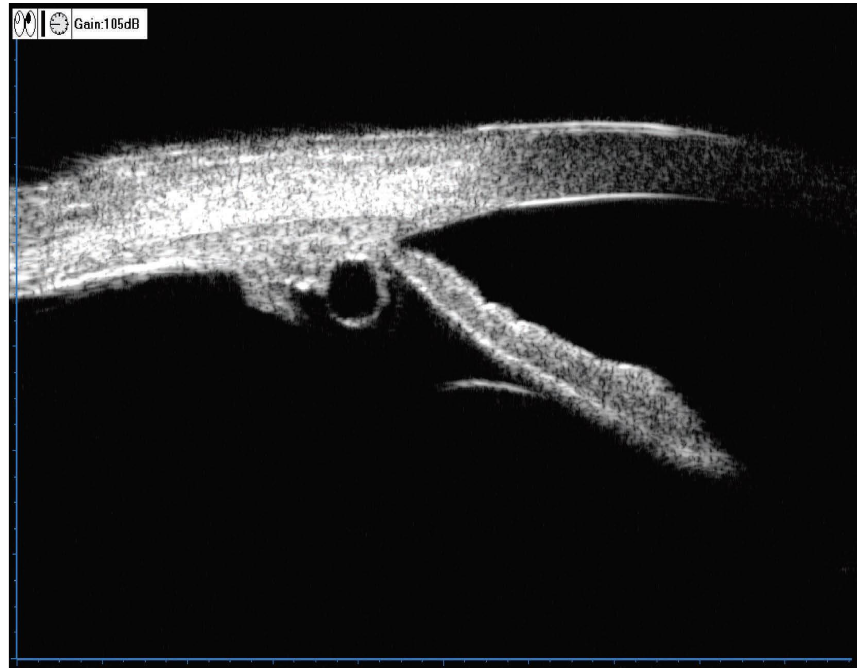
Figure 1: UBM images of one patient with a ciliary